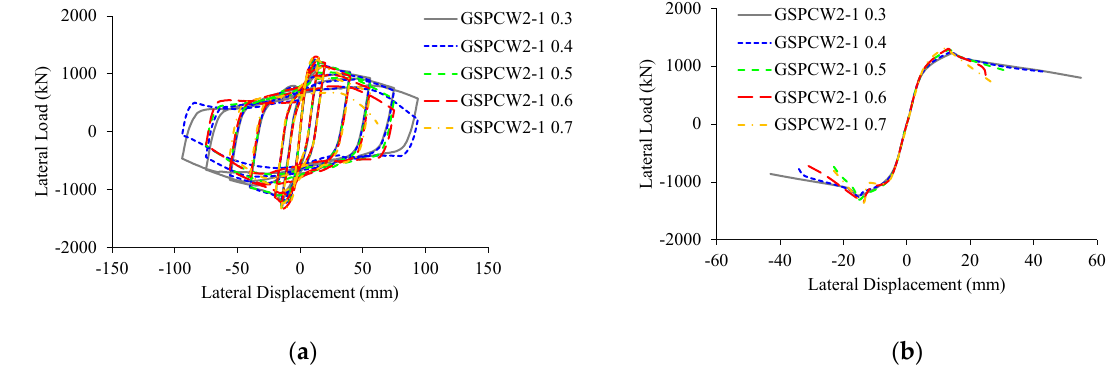
Figure 7. Influence of axial load ratio: ( a ) load–displacement hysteresis curves, and ( b ) skeleton curves.